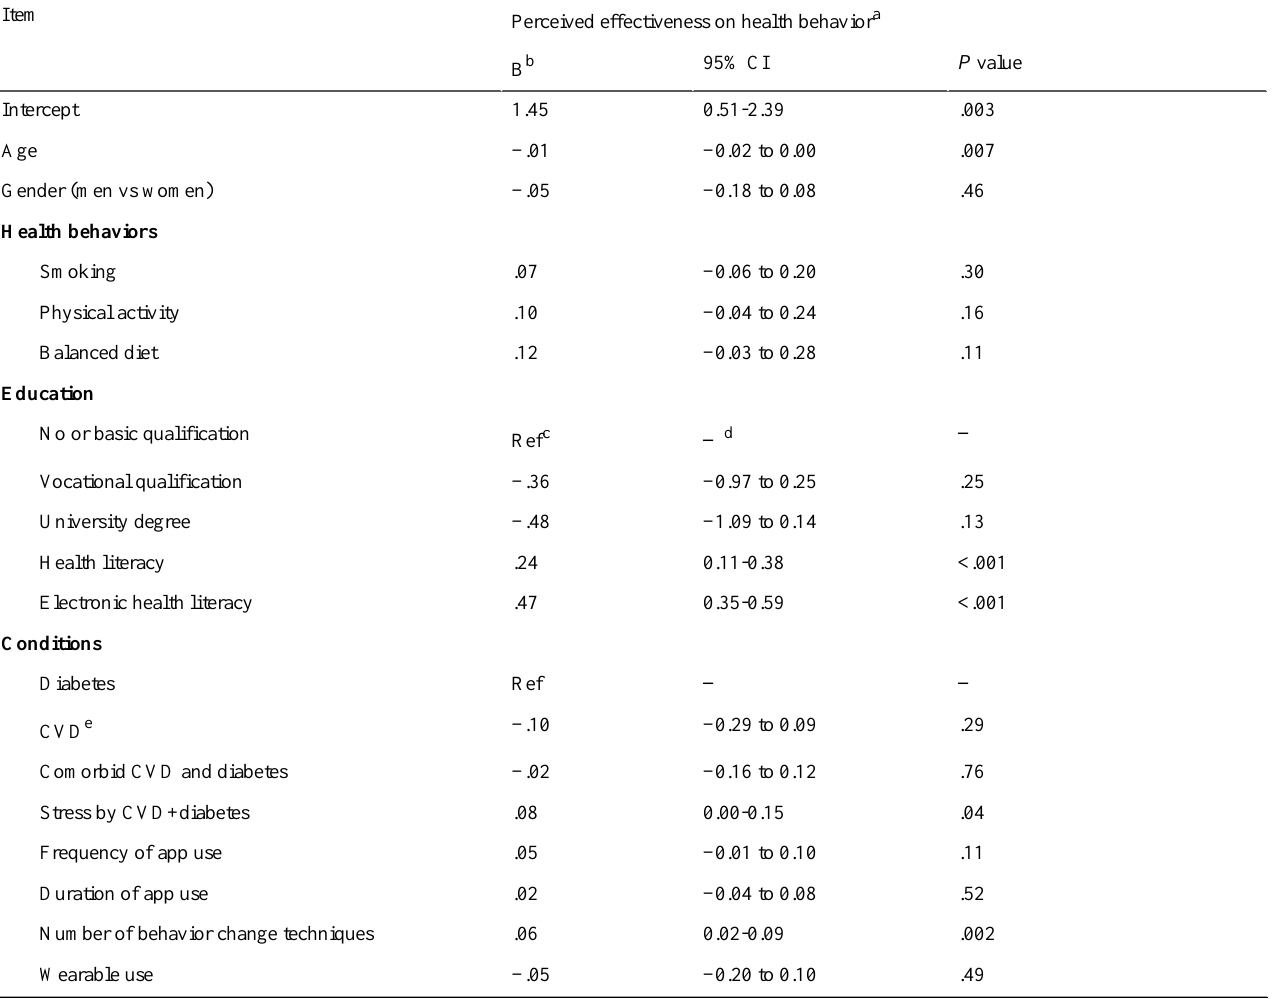
Table 4. Multivariate associations with the perceived effectiveness of the apps in all app users (N=402).